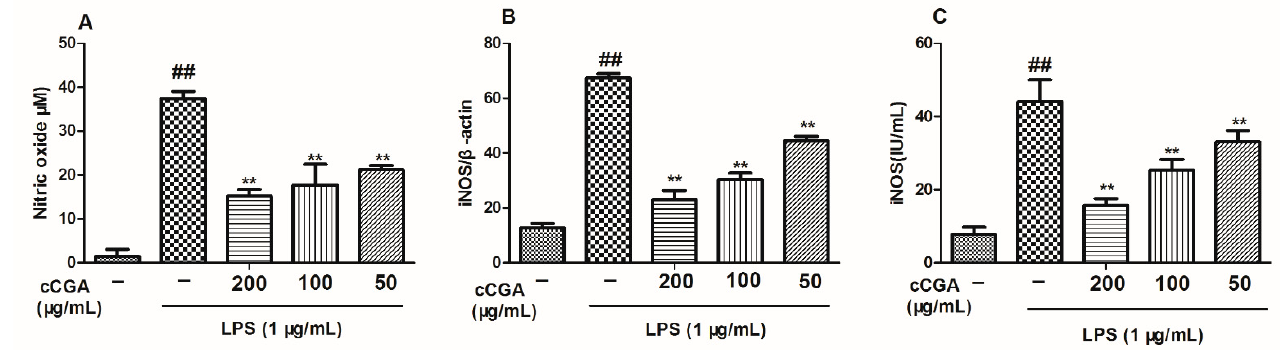
Figure 6. Effects of CCGA from A. adenophora on nitric oxide (NO) and iNOS production in LPS- induced RAW264.7 cells ( A ) Production level of NO after pretreatment with CCGA at 50–200 µ g/mL for 24 h and then stimulation by LPS (1 µ g/mL) for 16 h. ( B ) mRNA expression of iNOS after pretreatment with CCGA at 50–200 µ g/mL for 24 h and then stimulation by LPS (1 µ g/mL) for 16 h. ( C ) Protein levels of iNOS after pretreatment with CCGA at 50–200 µ g/mL for 24 h and then stimulation by LPS (1 µ g/mL) for 16 h. Notes: ## p < 0.01 vs. blank control group, ** p < 0.01 vs. LPS, n = 3 (mean ± standard deviation).